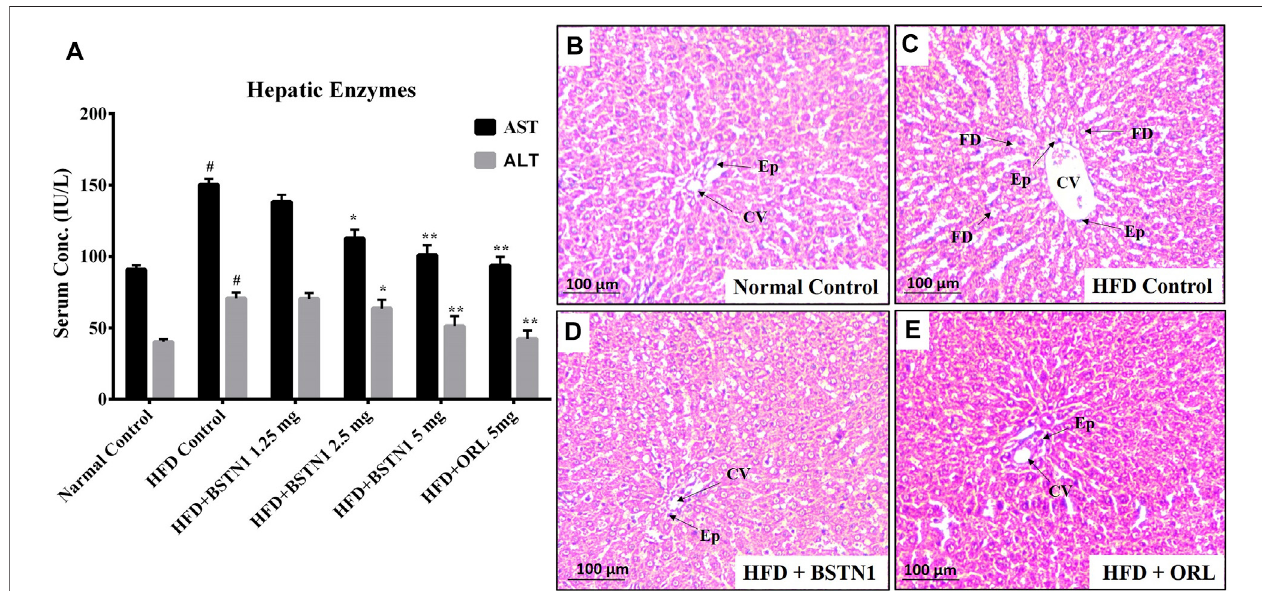
FIGURE 6 | Effect of BSTN1 on liver enzymes (AST and ALT) levels and liver tissue histology (40x magni fi cation). (A) Serum AST and ALT levels represented as mean ± SD, n (cid:2) 6. # denotes signi fi cant ( p < 0.001) difference between normal control and HFD control. * and ** denote signi fi cant difference between HFD control and treated groups at p < 0.05 and p < 0.01, respectively. (B) Histology ofnormal control hepatic tissue (C) HFD fed group showing disrupted tissuestructure with enlarged centralvein (D) HFD fed BSTN1 treatedgroup showing improvement inhepatic structure (E) HFD fedorlistat treatedgroup. CV, Central Vein;FD, FatDroplets and Ep, Epithelial cells. Scale bar: 100 µm.